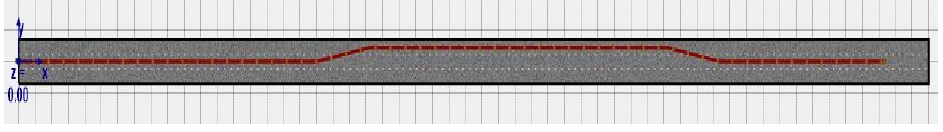
Figure 17. Vehicle track images.